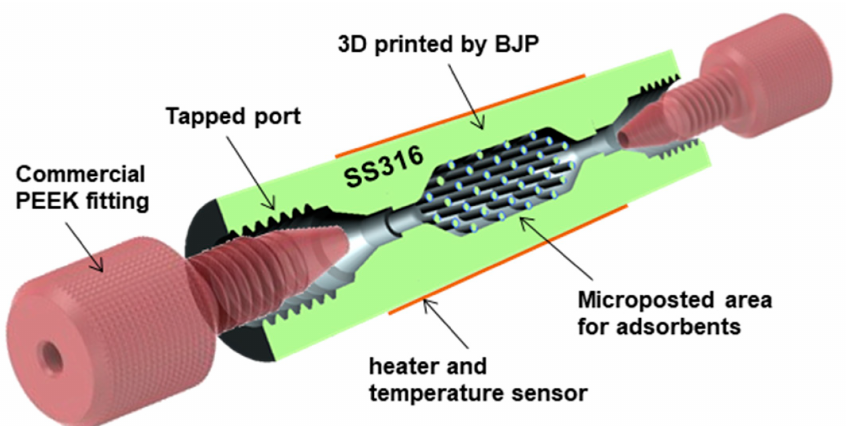
Figure 1. Schematic depiction of the binder-jet printed µ PC . Reprinted with permission from